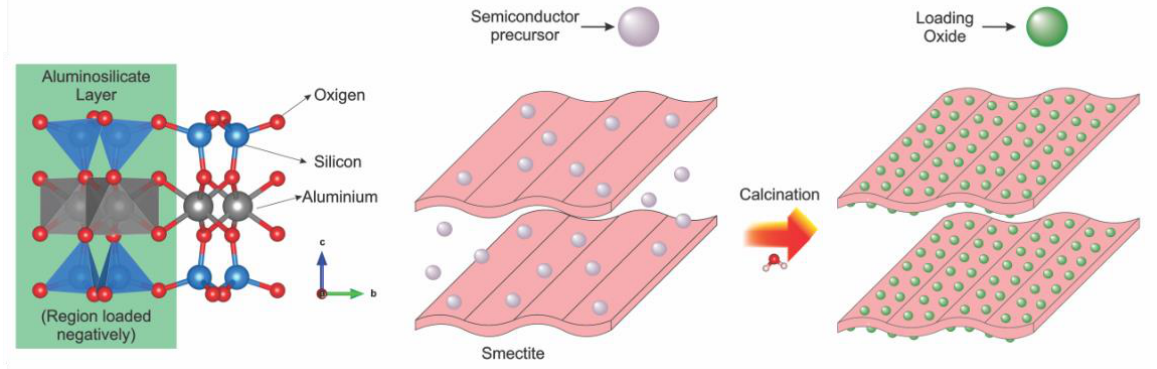
Figure 3. Proposal for the immobilization of different semiconductor oxides in the structure of smectites.